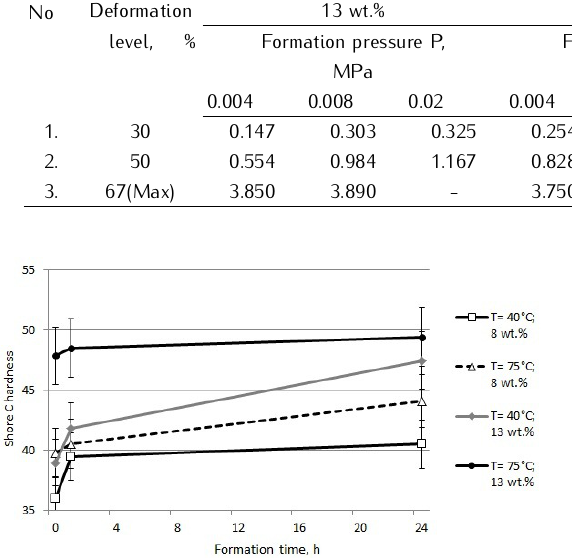
Table 2. The influence of formation pressure of composite material specimens (polymer binder with - NCO 2.4 %; formation at Ta = 17 - 20 ◦ C) on the compressive stress at different deformation levels. Compressive stress, MPa Polymer binder content, Polymer binder content, Polymer binder content, Deformation No